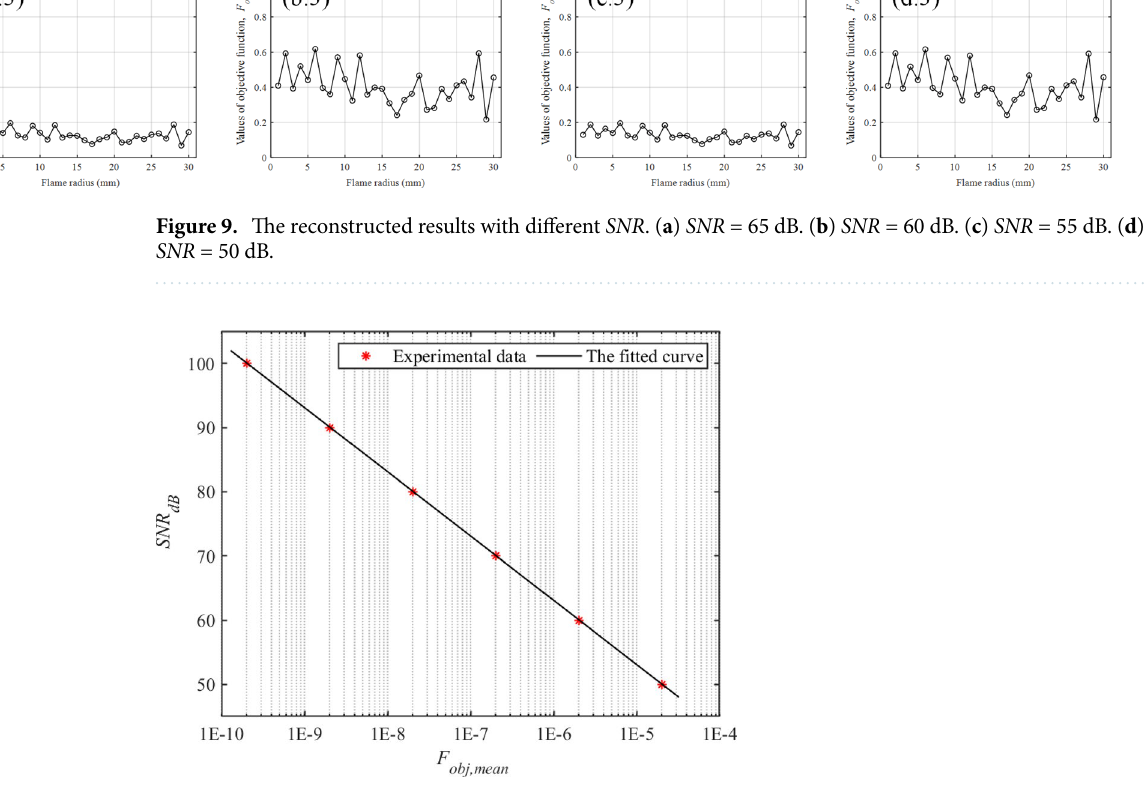
Figure 10. For a fixed stream of random numbers, the fitted curve with SNR of 50, 60, 70, 80, 90 and 100 dB according to Eq.